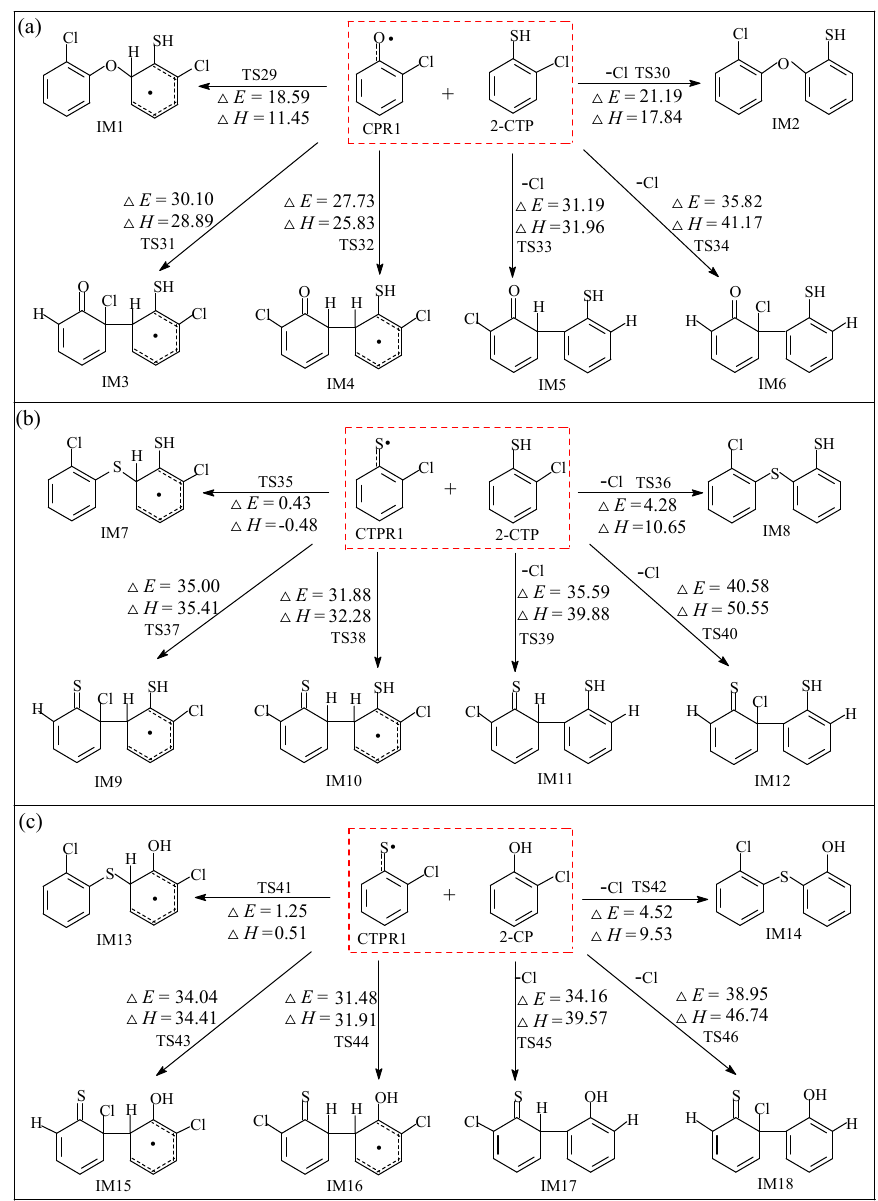
Figure 3. Pre-PCTA/PT/DT/DF formation routes embedded with the potential barriers ∆ E (in kcal/mol) and reaction heats ∆ H (in kcal/mol) from the cross-condensation reactions of CPR1 with 2-CTP ( a ), CTPR1 with 2-CTP ( b ), and CTPR1 with 2-CP ( c ). ∆ H is calculated at 0 K.